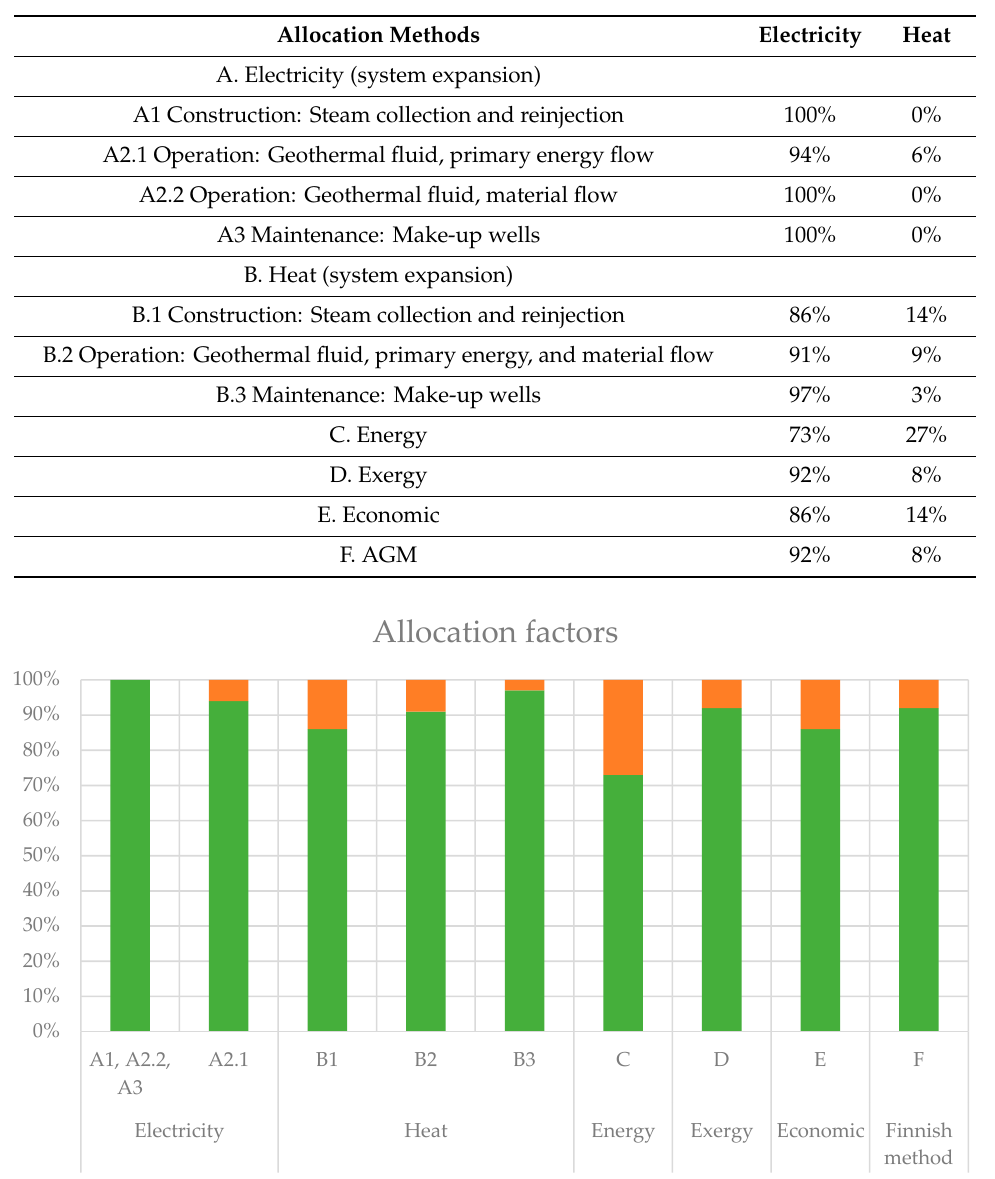
Table2. Resultsfortheallocationfactorsresultingfromthedi ff erentallocationmethodsA–Finvestigated in the study.